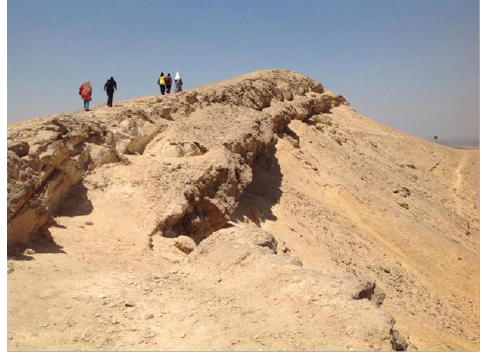
Figure 8a: El- Hassana Dome, (domal structure) near the end of the Abu Roash Aburoash area and the end of the deformation, this dome is currently within recorded as a protected area.